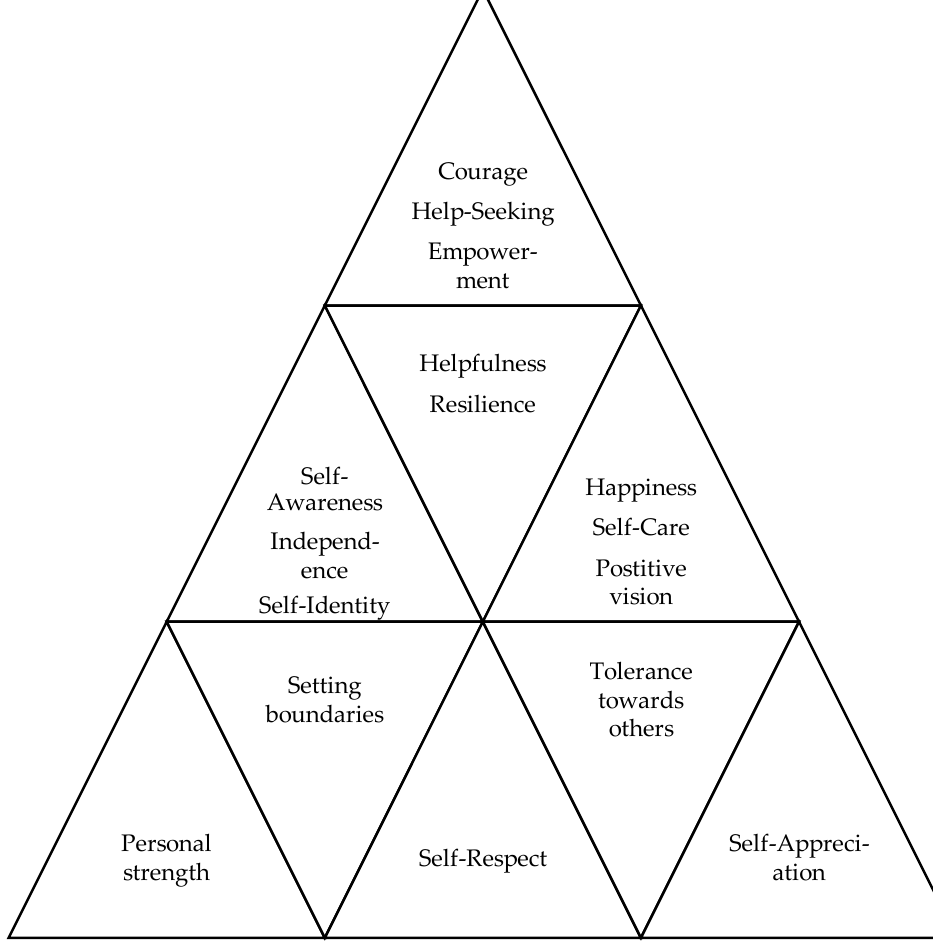
Figure 2. Experience of post-traumatic growth by female survivors of intimate partner violence. Note